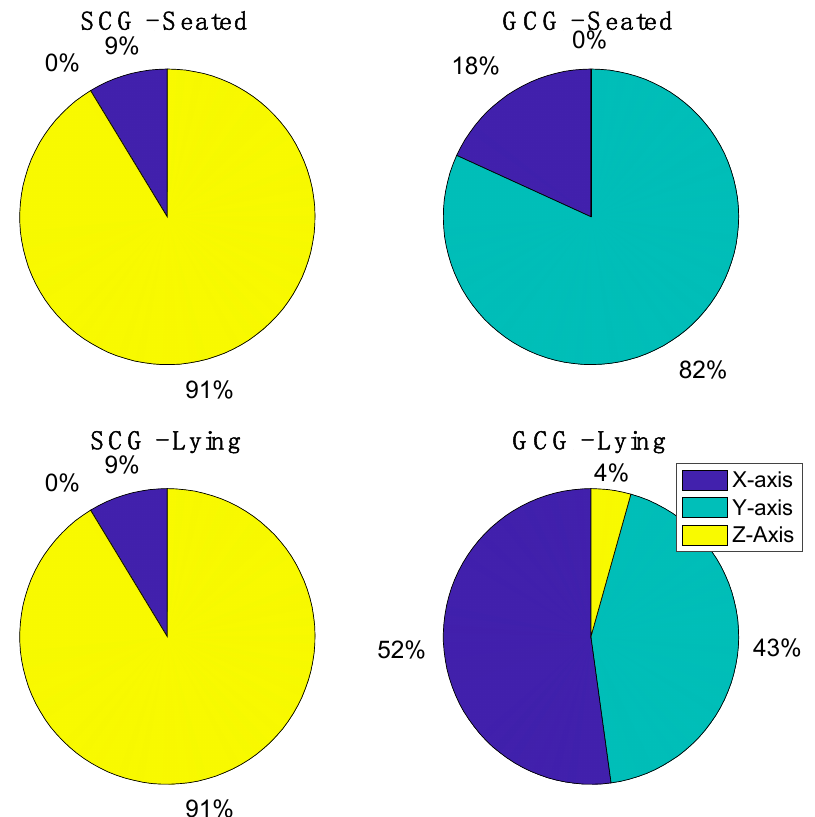
Figure 5. Percentage of selected axes used to retrieve the SCG signals and GCG signals from algorithm 2.